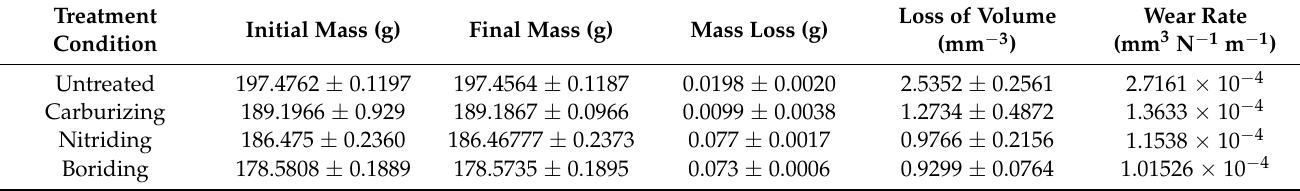
Table 8. Volume loss as a function of the different hardening